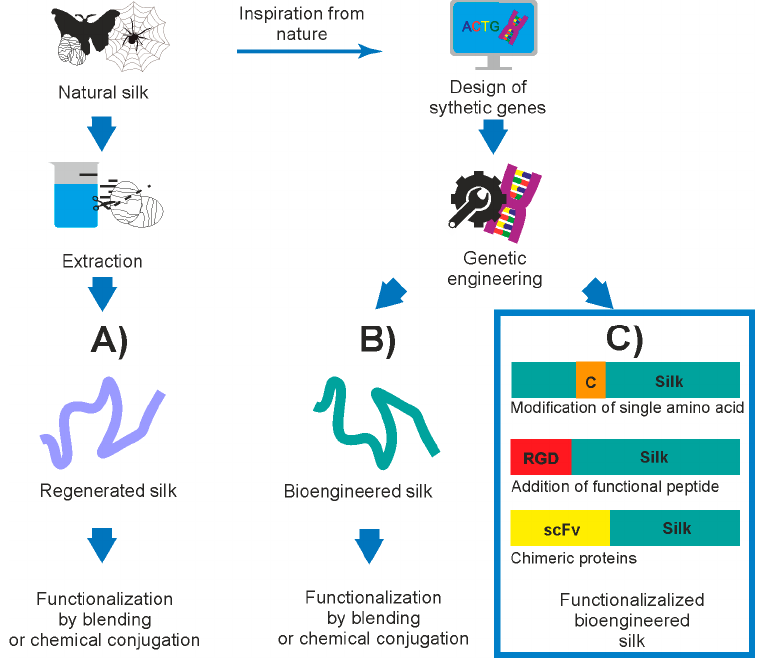
Figure 1. Strategies for acquiring and possibly functionalization of silk proteins. ( A ) Silk can be obtained directly from nature and, after the extraction, can be functionalized by blending with other compounds or by chemical conjugation; ( B ) knowledge of the interplay among the sequence-structure properties of silk proteins enables the design of synthetic genes, and then the bioengineered silk is produced in the heterologous host. The bioengineered silk can be further functionalized by blending with other compounds or by chemical conjugation; ( C ) genetic engineering enables the direct functionalization of silk. The silk sequence can be modified at the DNA level so that, after production in the heterologous host, a functionalized bioengineered silk is obtained. The modifications can refer to addition/substitution of a single amino acid or to fusion of a peptide or a fragment (domain) of another protein. This review covers the functionalization of silk through genetic engineering.